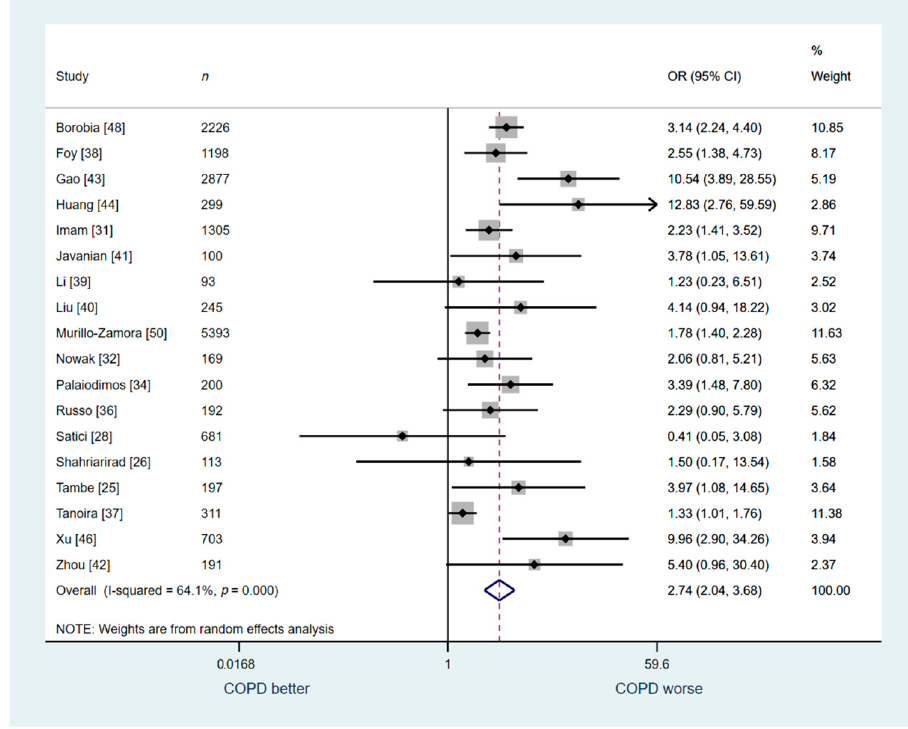
Figure 4. Analysis of the studies that included only general patient population: COPD vs. no COPD for in ‐ hospital mortality.